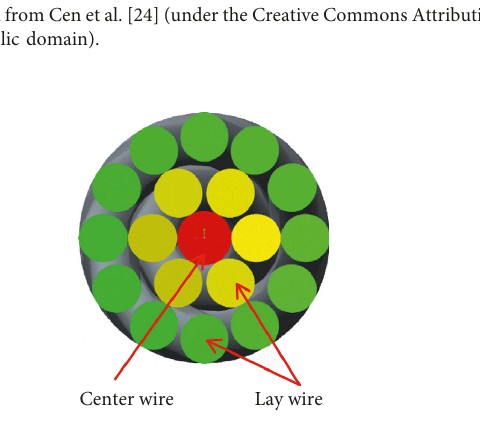
Figure 3: The 1+6+12 single-strand wire rope. Table 2: Diameter of wire for single strands with different diameter ratios (mm).